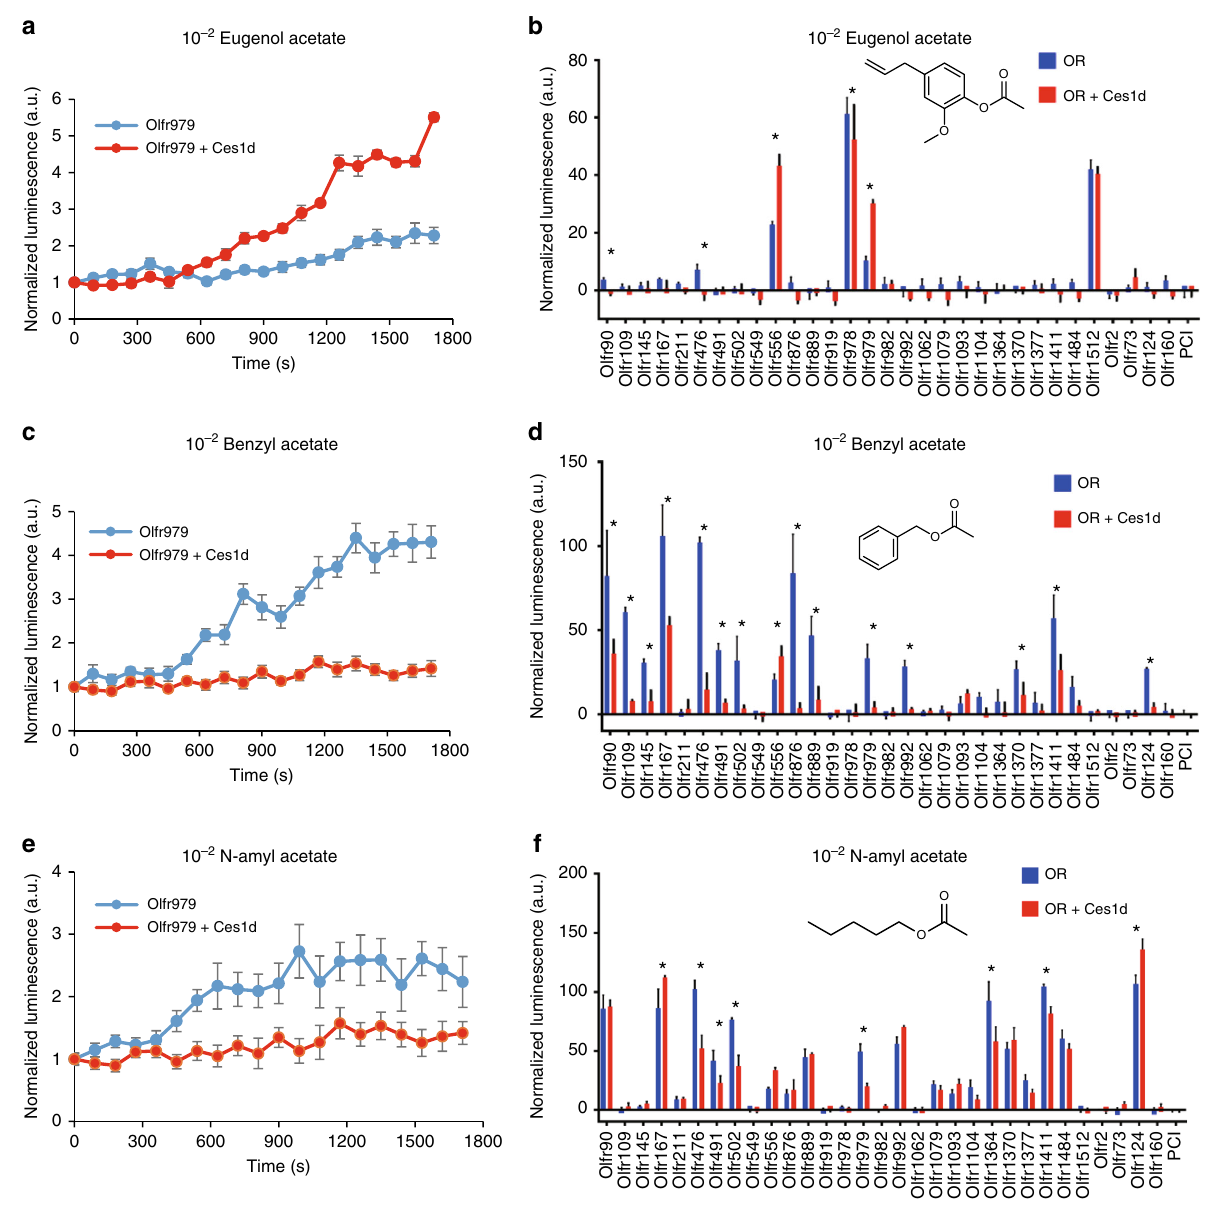
Fig. 7 Effect of co-expression of Ces1d with ORs. Real time measurement of Olfr979 to a Eugenol acetate, c Benzyl acetate and e N-amyl acetate. Ces1d enhanced activation of Olfr979 to Eugenol acetate, but suppressed the activation of Olfr491 to benzyl acetate and N-amyl acetate. Error bar indicates s.e.m. ( n = 3). b – f Identi fi cation of OR and odorant pair that change the activation with 1% odorant by Ces1d co-expression. The bars show that each normalized AUC value of OR only (red) and Ces1d (blue). Error bars indicate s.e.m. ( n = 3). Statistical signi fi cance was assessed with FDR correction (* p < Methods DNA and vector preparation . The open reading frames of ORs were ampli fi ed using Phusion polymerase (Thermo Fisher Scienti fi c). Ampli fi ed fragments were cloned into pCI expression vector (Promega) containing the sequence encoding the fi rst 20 amino acids of human rhodopsin (Rho-tag) at the N-terminal 30 . The cDNA of Ces1d was ampli fi ed using Phusion polymerase from the cDNA library of mouse olfactory epithelium and cloned into pCI expression vector without any tag. The sequences of the cloned receptors were veri fi ed by sequencing (3100 Genetic Analyzer, Applied Biosystems). Cell culture . Hana3A cells 61 were maintained in minimal essential medium (MEM) containing 10% FBS (vol/vol) with penicillin-streptomycin and ampho- tericin B at 37°C and 5% CO2. These cells were authenticated using polymorphic short tandem repeat (STR) at the Duke DNA Analysis Facility using GenePrint 10 (Promega) and shown to share pro fi les with the reference (ATCC). No myco- plasma infection was detected.